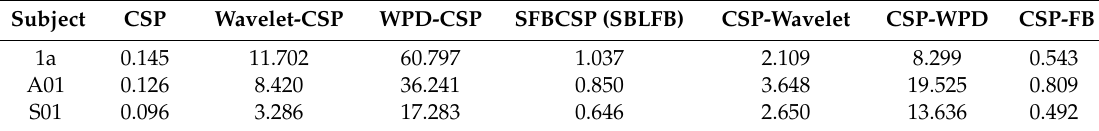
Figure 9. SFBCSP and SBLFB optimized with secondary feature selection (All data). Table 15. Feature extraction time of training set for each method (Unit: second).